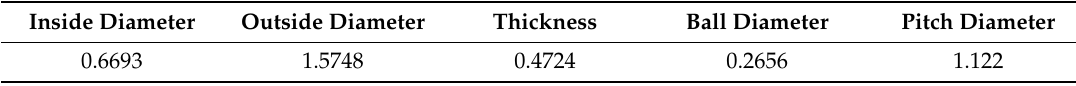
Table 3. Fan end bearing size (inch).